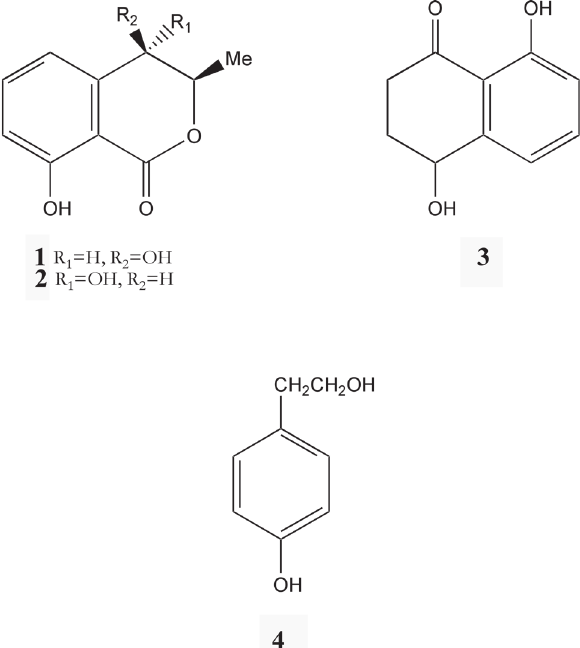
Figure 1. Structures of (3 R ,4 R )-(-) -4-hydroxymellein, (3 R ,4 S )-(-) -4-hydroxymellein, isosclerone and tyrosol ( 1 - 4